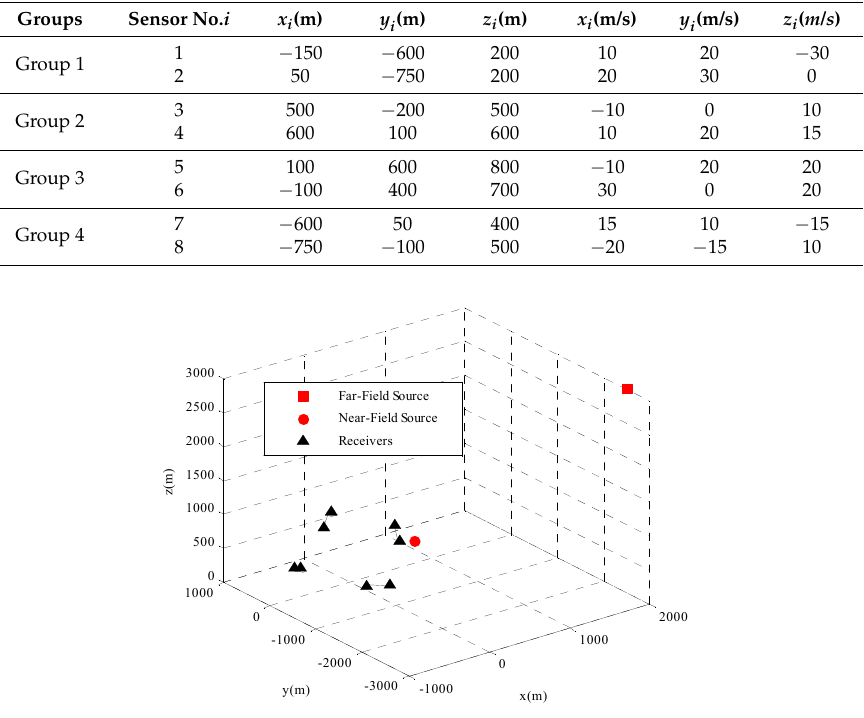
Figure 2. Localization geometry for simulation.